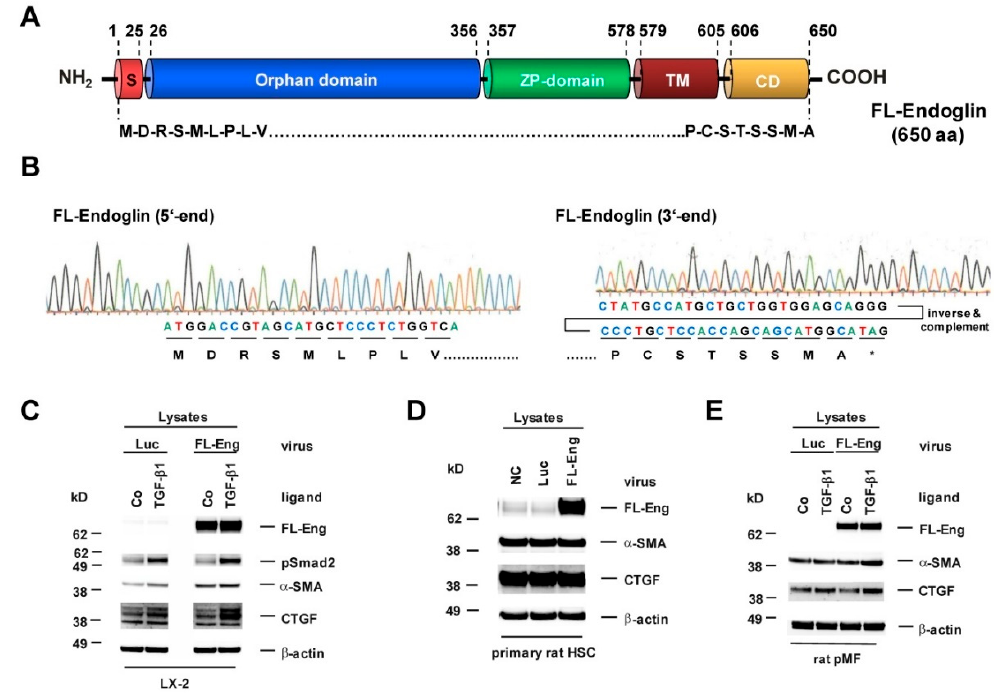
Figure 2. Structure, sequence analysis and functional expression of a virus coding for full-length Endoglin from rat. ( A ) The full-length endoglin (FL-Eng) form is composed of a signal peptide, an orphan domain, a zona pellucida (ZP) domain, a transmembrane region (TM), and a cytosolic domain (CD). Amino acid positions spanning individual regions are numbered. ( B ) Sequence analysis of FL-Eng expression plasmid. For clarity the sequence data of the 3 (cid:48) end was inversed and complemented for depicting the encoded amino acids. ( C – E ) Human LX-2, primary rat HSC and pMF were infected with a control virus (Luc), FL-Eng or left untreated (NC). Thereafter, cells were treated or not with TGF- β 1 (1 ng / mL) for 24 h ( C , D ), 48 h ( E ) or cultured without any treatment (Co) ( D ). Cells were harvested and proteins analyzed using Western blot for transgene expression (FL-Eng), connective tissue growth factor (CTGF) and α -smooth muscle actin ( α -SMA) or activation of Smad2 (pSmad2). Equal loading of lanes was proven by re-hybridization of the membranes with an antibody specific for β